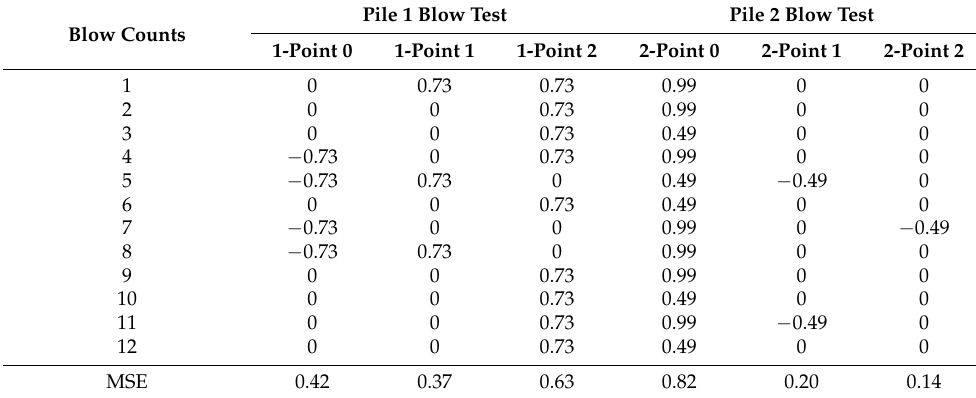
Table 3. Measurement Accuracy of